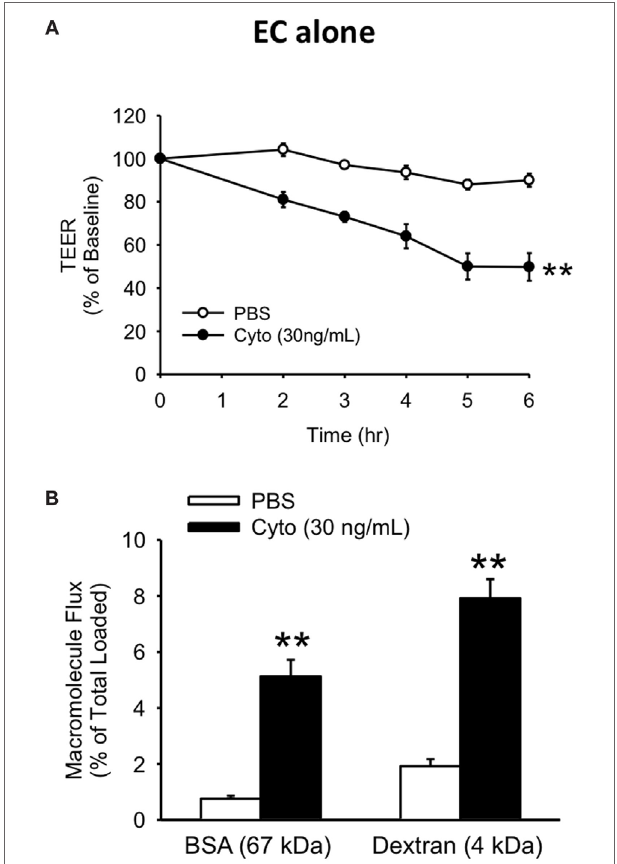
FigUre 1 | Cytomix induces significant loss of human PMVEC barrier function. Cytomix-stimulated PMVEC cultured alone had significantly increased permeability that peaked by 5 h post-stimulation and persisted at 6 h post-stimulation vs. PBS by three assays: lower transendothelial electrical resistance (TEER) (a) and higher macromolecular flux including Evans blue-bovine serum albumin (BSA) and fluoroisothiocyanate-dextran (B) . ** p < 0.01 compared with respective PBS (repeated measures two-way ANOVA or t -test). n = 6. Note: for the sake of simplicity, the term EC refers specifically to PMVEC within all